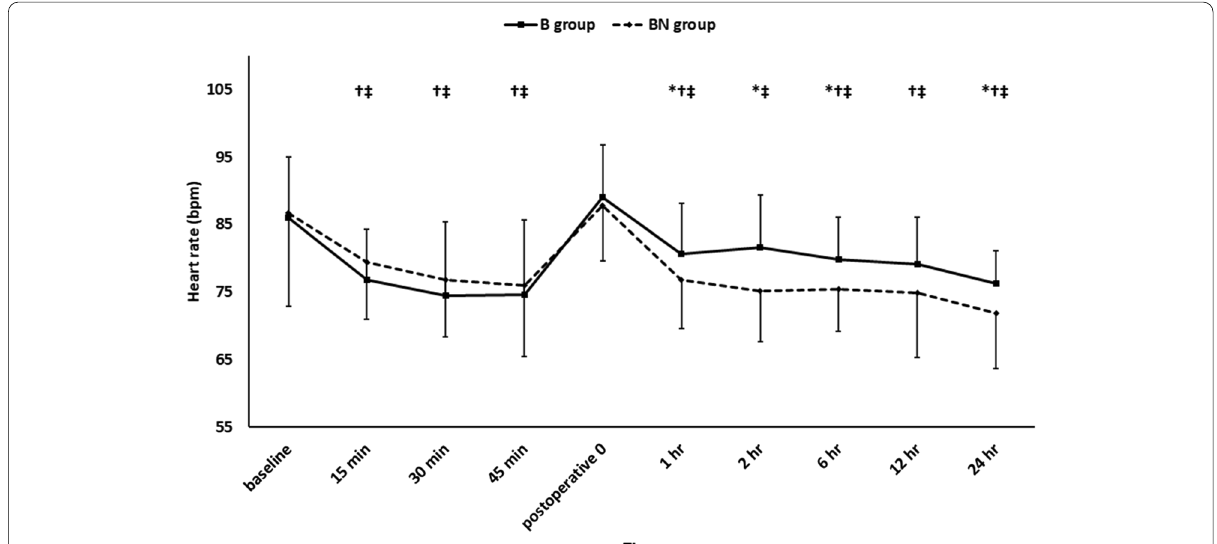
Fig. 2 Heart rate. Markers are means, and error bars are standard deviations. * denotes significance between the 2 groups, † denotes significance in relation to the baseline reading in the B group, and ‡ denotes significance in relation to the baseline reading in the BN group